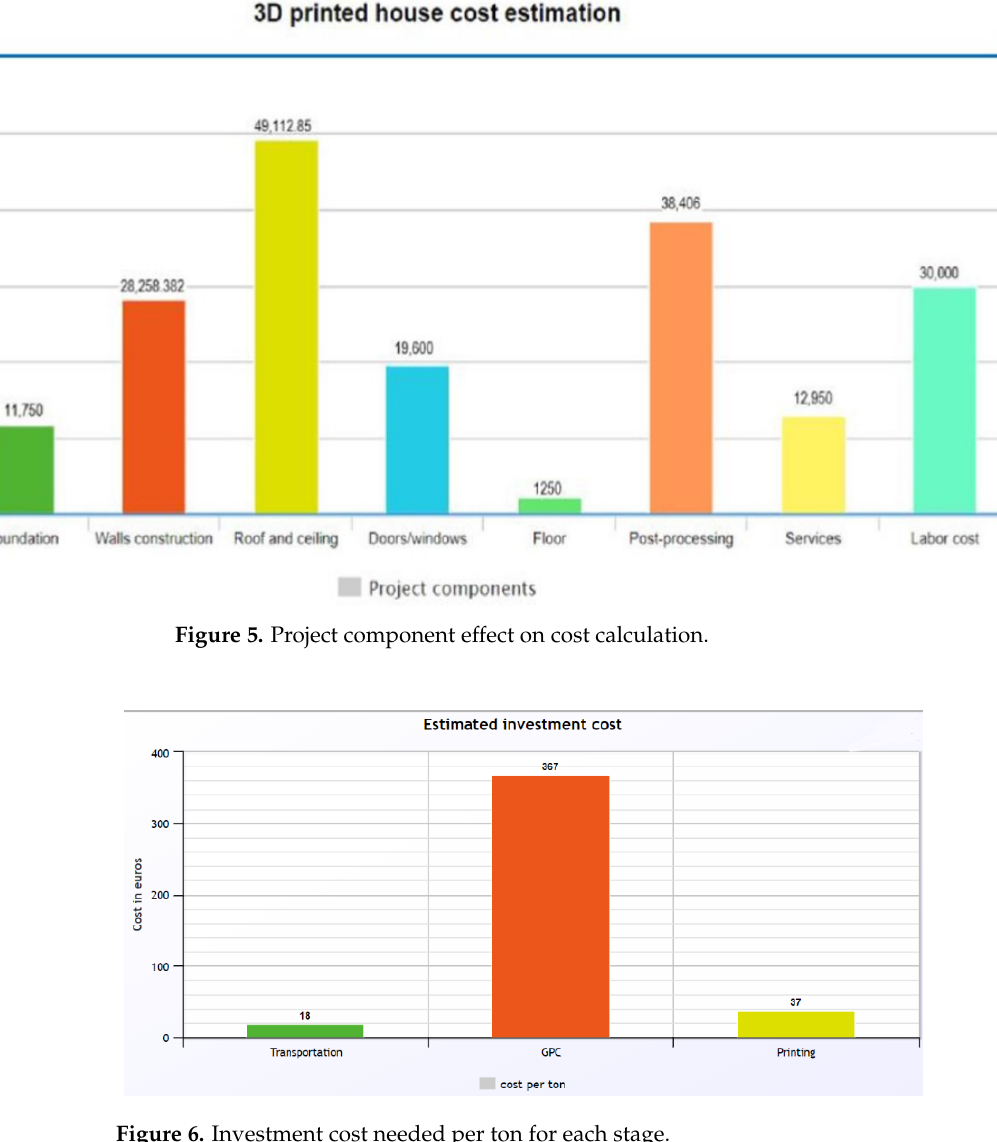
Figure 6. Investment cost needed per ton for each stage. Table 11. Capital and operating expenditures needed for geopolymer 3D printing.